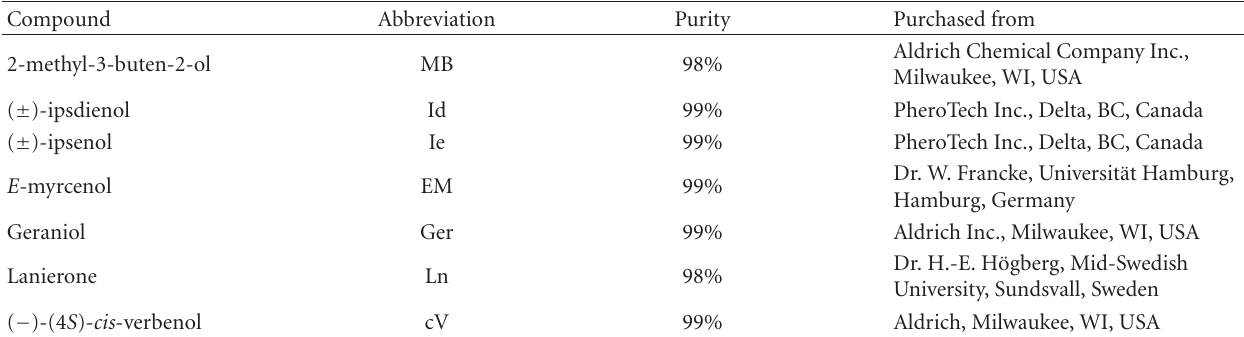
Table 1: Compounds used in field bioassays: abbreviation, purity, and source.